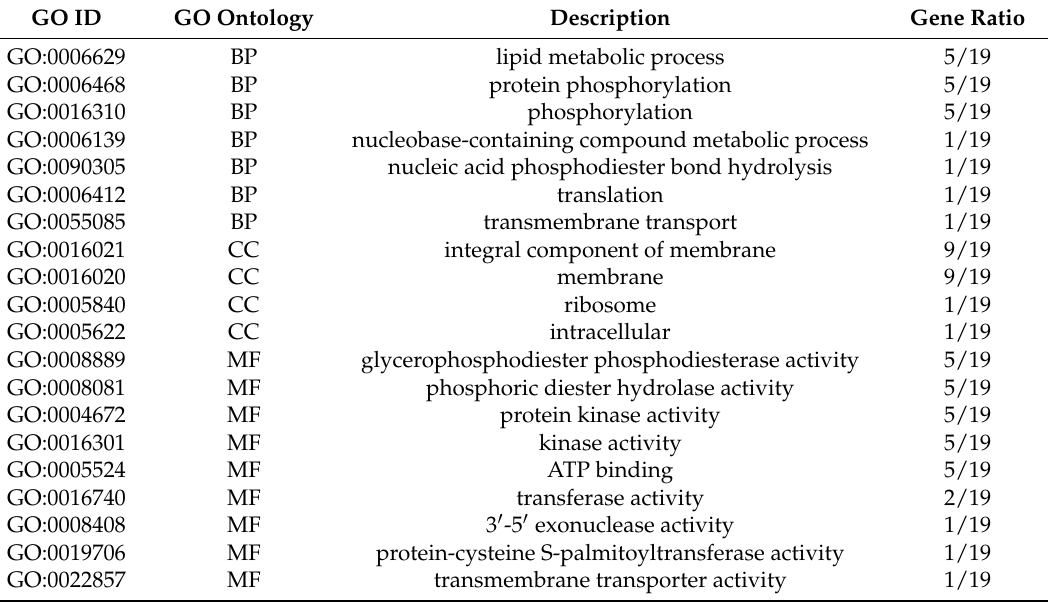
Table 3. GO category of targets of novel DEMs identified by